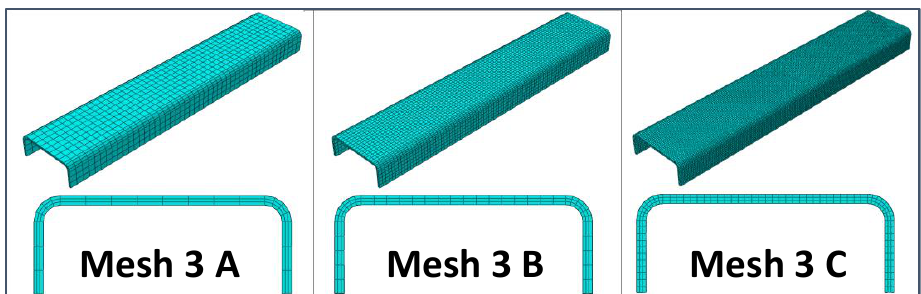
Figure 3. One element in the thickness direction: Coarser mesh (Mesh 1A), intermediate mesh (Mesh 1B), and finer mesh (Mesh 1C).